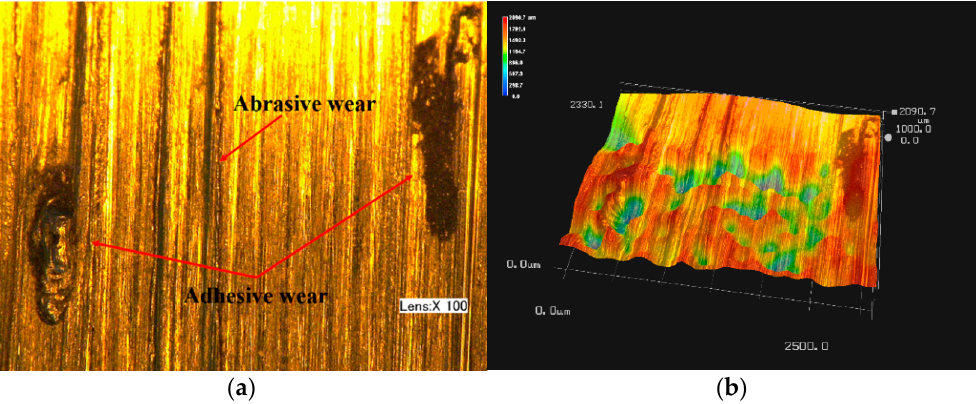
Figure 8. Micrographs of the first specimen: ( a ) 2D micrographs; ( b ) 3D micrographs. Appl. Sci. 2018 , 8 , x